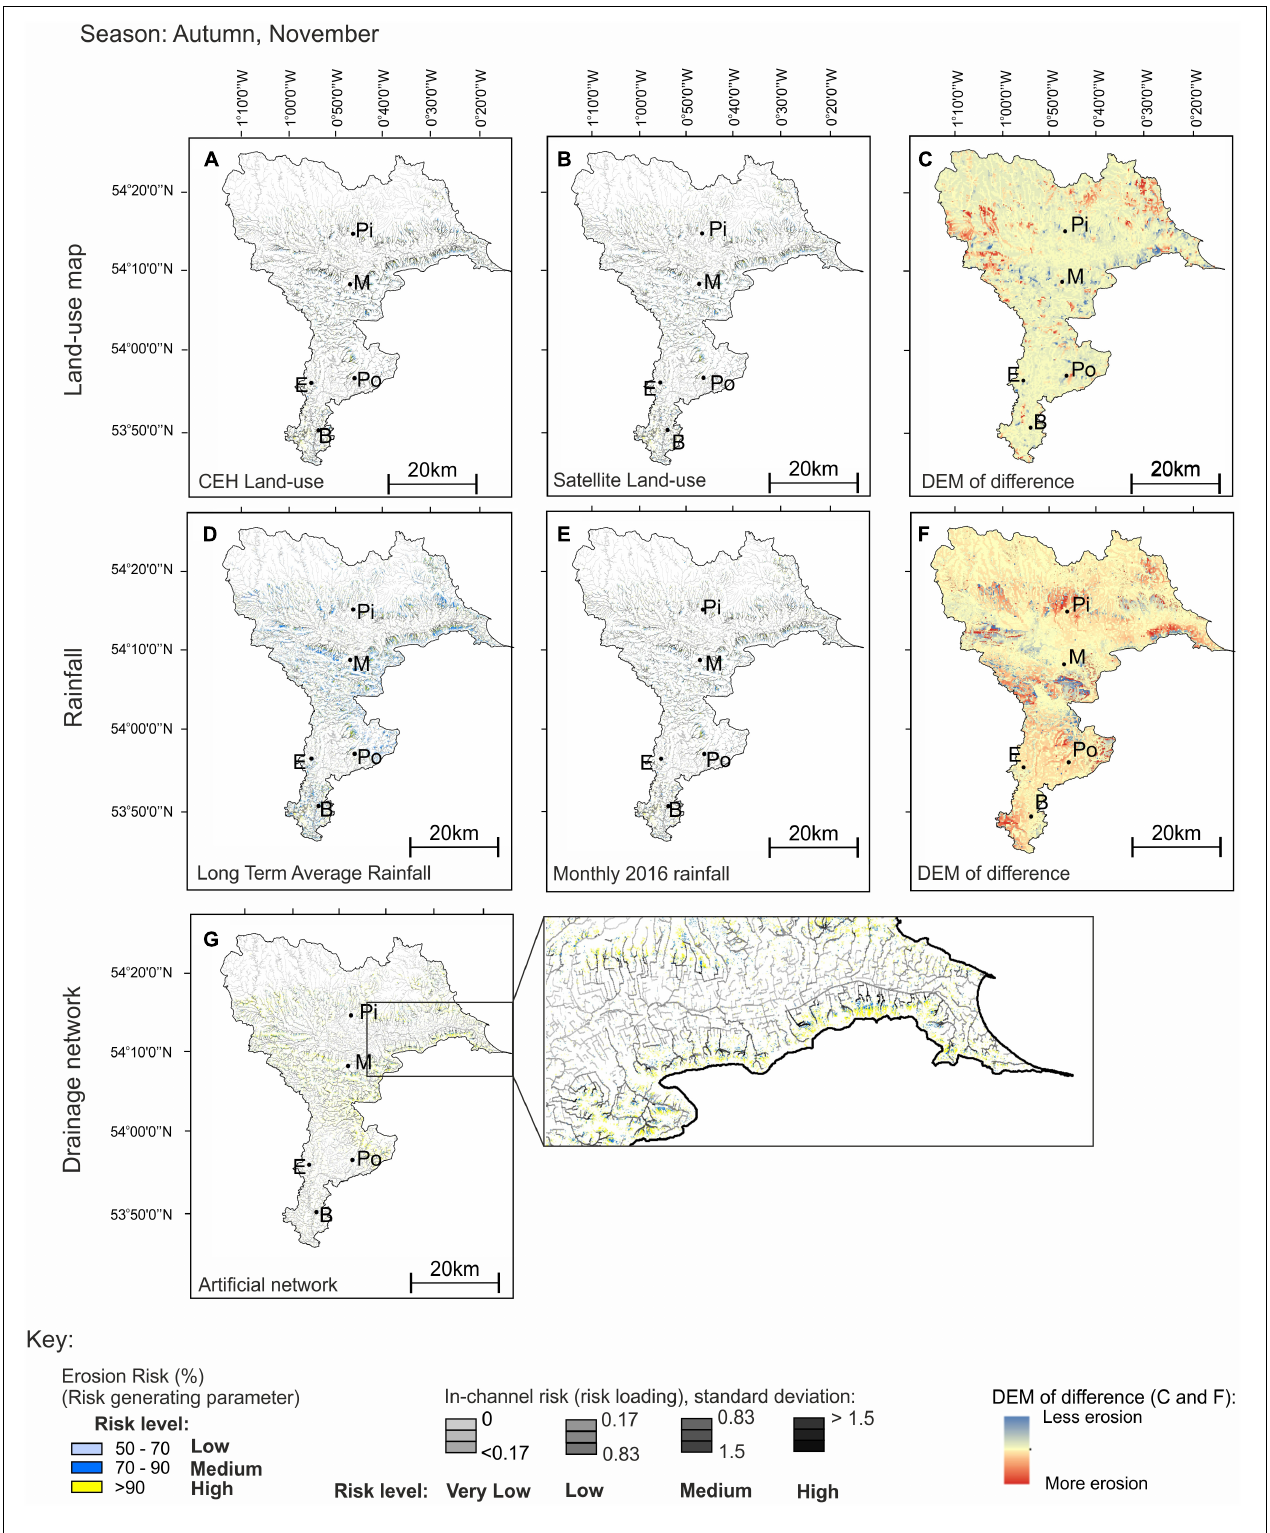
FIGURE 6 | Model scenario outputs for November, (A) CEH land use map; (B) satellite-derived land use map; (C) the DEM of difference between the two land use maps; (D) long-term rainfall average; (E) monthly rainfall totals; (F) the DEM of difference between the two rainfall scenarios; and (G) the artificial drainage network. Locations are shown on each map; Pi, Pickering; M, Malton; Po, Pocklington; E, Elvington; B, Bubwith.